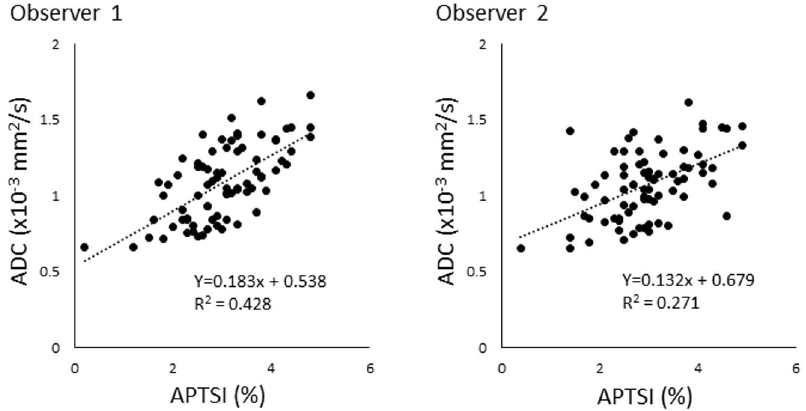
Figure 2. Scatter plots showing the relationships between APTSI and ADC for observers 1 and